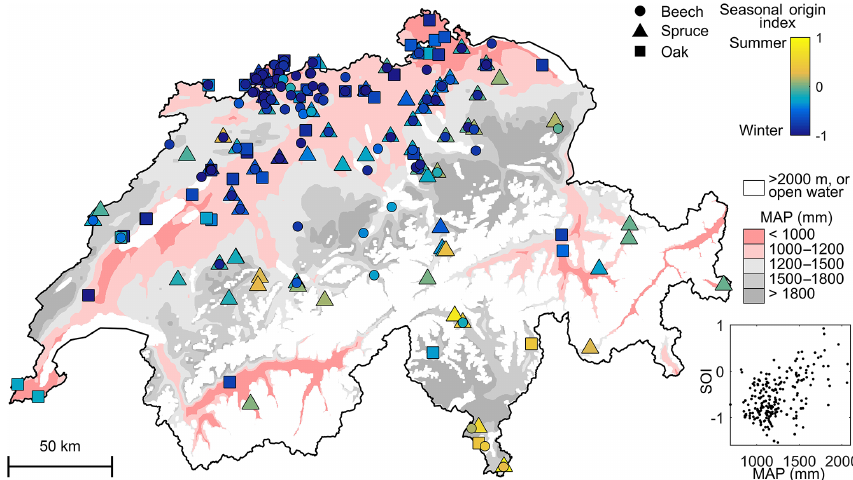
Figure 6. Variation in seasonal origins of tree xylem water with mean annual precipitation (MAP) across Switzerland. Open water and elevations > 2000ma.s.l. are excluded. In all but the wettest regions, the seasonal origin index shows a predominance of winter precipitation in tree